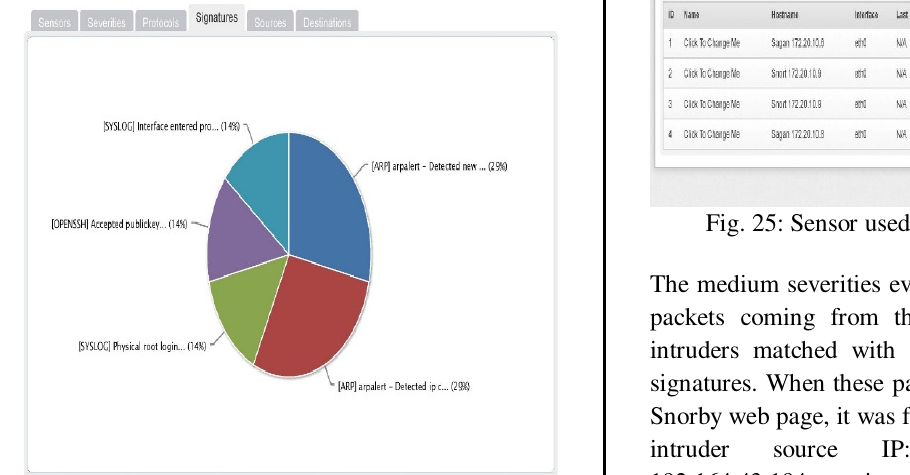
Fig. 22: Attack signatures